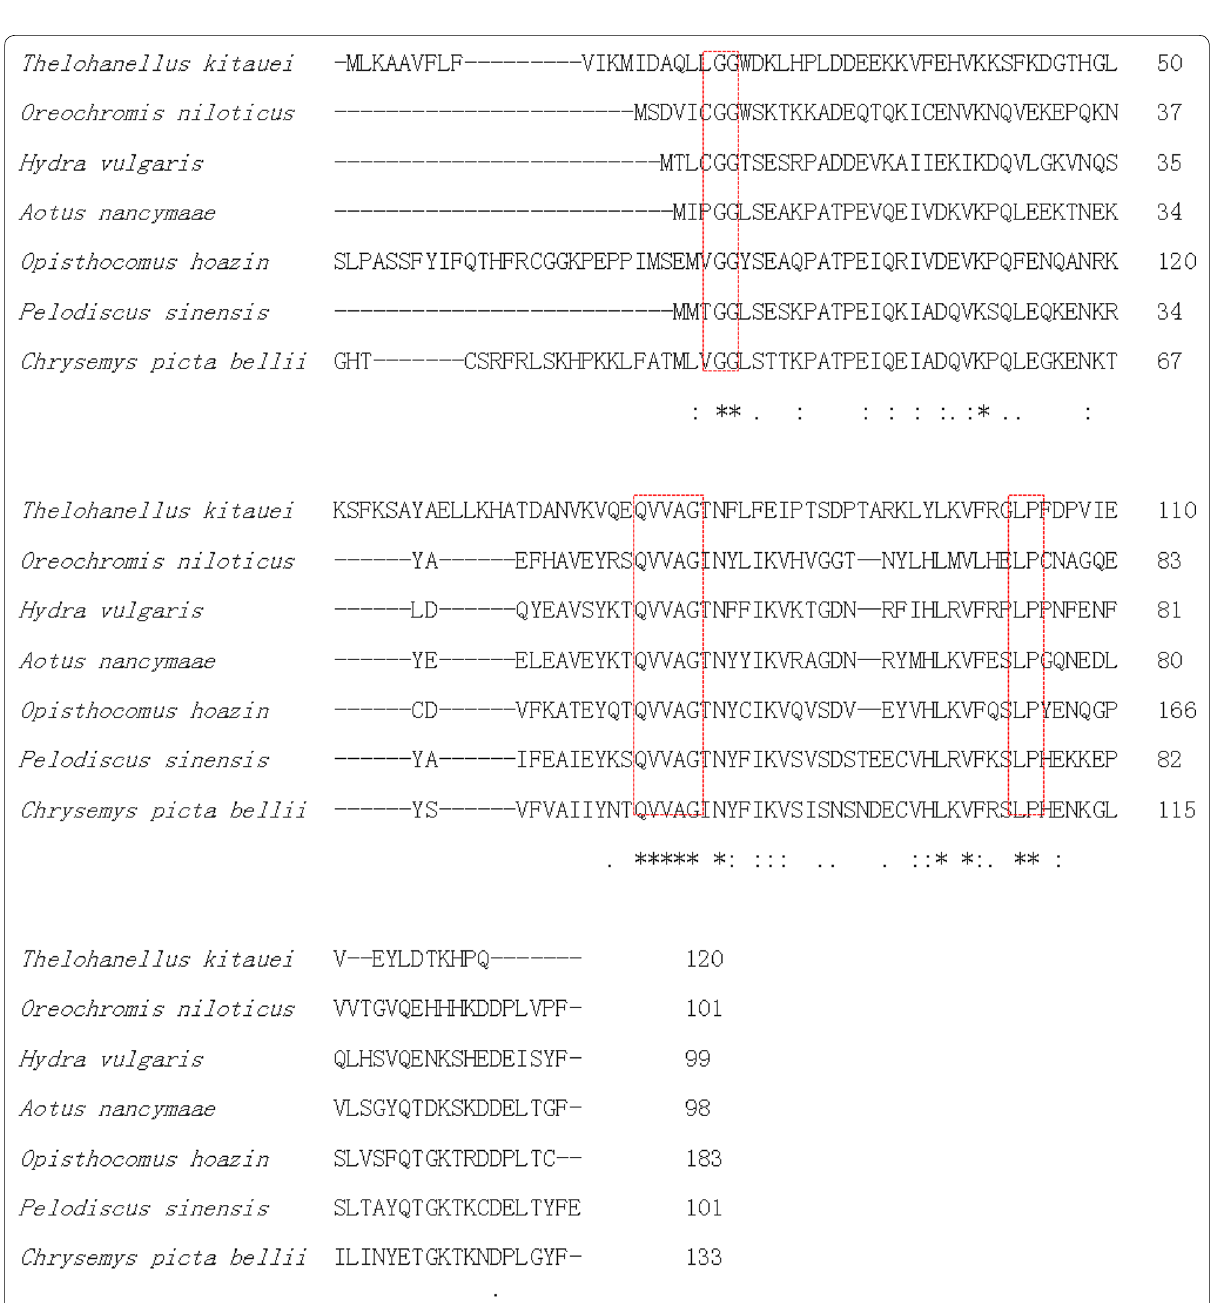
Fig. 4 Multiple sequence alignment of TK-cystatin with other cystatins from different species. The analysis was performed by ClustalW. The numbers on the right represented the positions of the amino acids of the different sequences. The asterisk in the bottom row represented consistent sequence in different sequences. Three activity-related conserved motifs in cystatin-type protein were boxed in